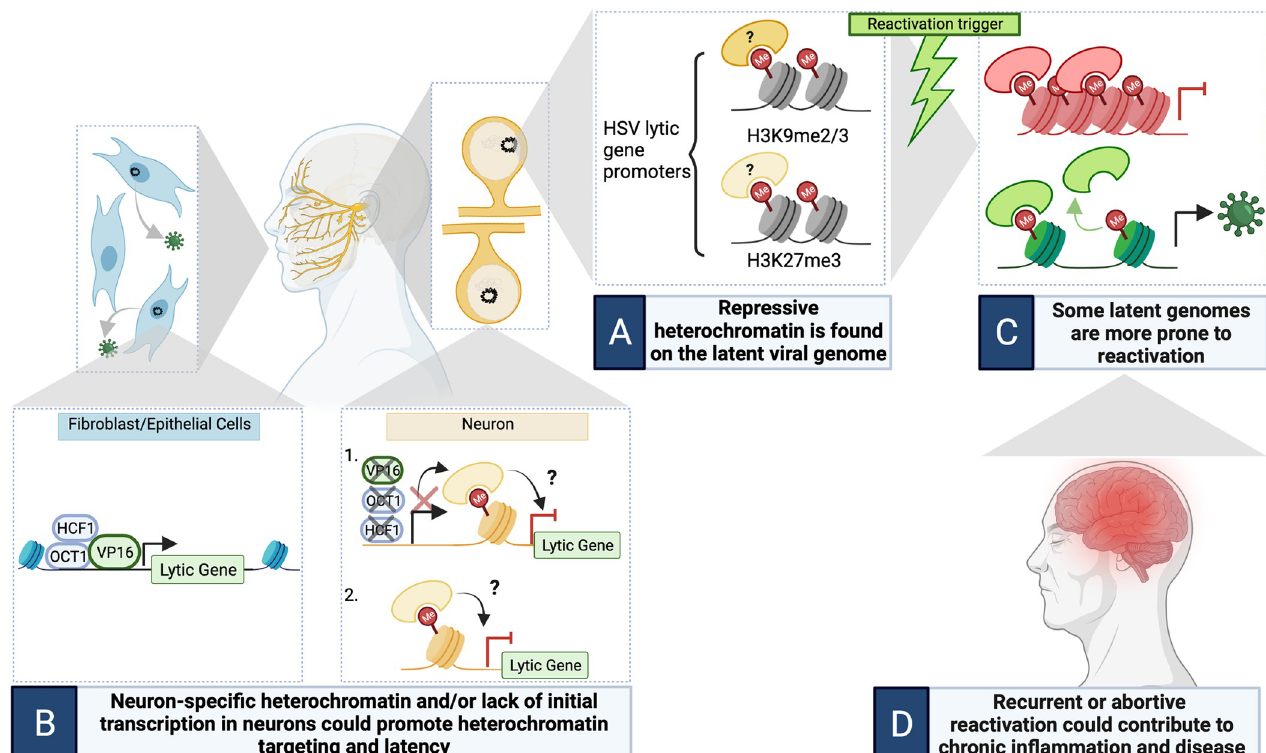
Fig 1. The epigenetics of HSV latency. (A) Repressive heterochromatin is found on the latent viral genome. The repressive heterochromatin marks H3K9me2/3 and H3K27me3 are both known to be enriched on the latent viral genome and have a restrictive effect on the viral DNA. What histone readers associate with these marks and the effects of various histone readers on viral DNA is unknown. (B) Neuron-specific heterochromatin and/or lack of initial transcription in neurons could promote heterochromatin targeting and latency. (B1) Heterochromatin could form on the HSV genome secondary to reduced viral transcription to maintain silencing. (B2) Neuron-specific heterochromatin types may directly repress HSV gene expression. The mechanisms of heterochromatin targeting to the HSV genome in neurons are not understood. (C) Some latent genomes are more prone to reactivation. After a reactivation stimulus, only a subpopulation of latent genomes will reactivate. The differences in histone PTMs, histone associated proteins, and overall 3D compaction of the viral genome could contribute to the heterogeneity of reactivation. (D) Recurrent or abortive reactivation from HSV genomes in an epigenetic state more prone to reactivation could contribute to chronic inflammation and disease. HSV infection potentially contributes to neurological disease, such as late onset Alzheimer disease, potentially via recurrent reactivation, leaky latency, and prolonged inflammation. Figure created with BioRender.com. H AU : AnabbreviationlisthasbeencompiledforthoseusedthroughoutFig 1 : Pleaseverifythatallentriesarecorrect : SV, herpes simplex virus; PTM, posttranslational